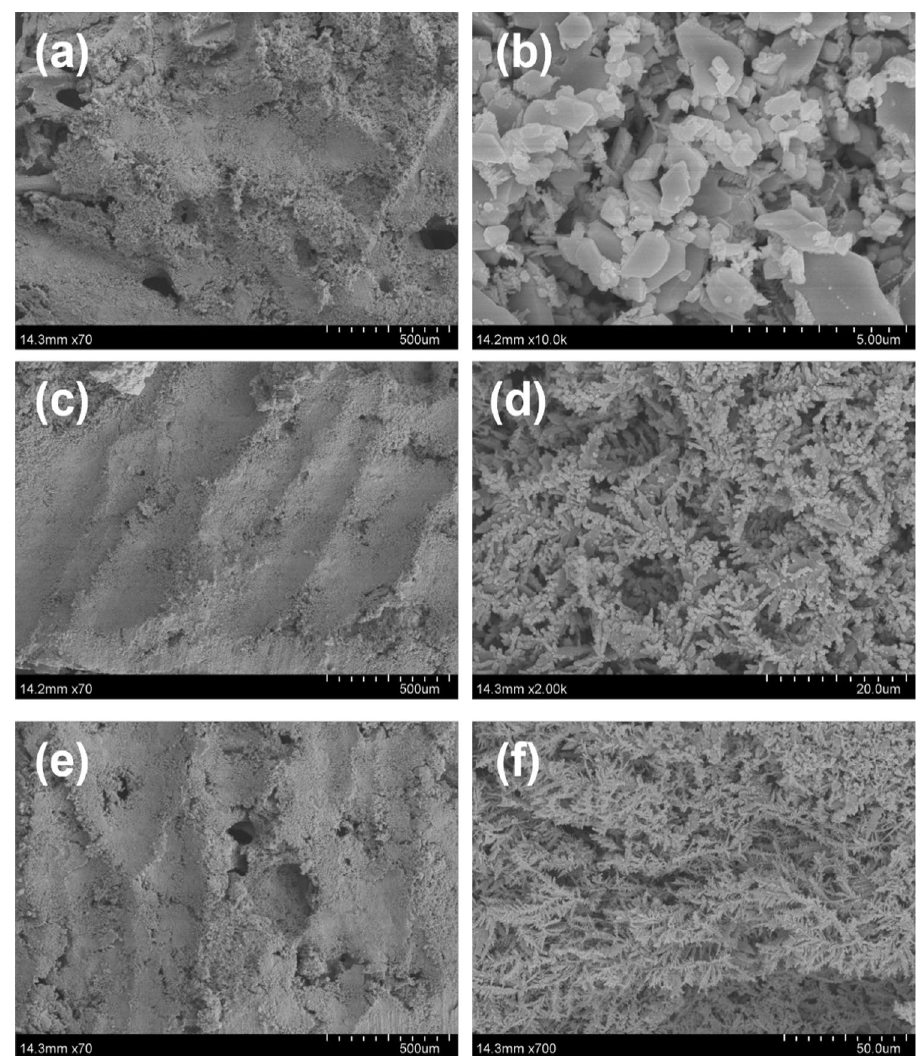
Fig. 2 Scanning electron microscope images of silver dendrites on the surface of copper foam by electrochemi- cal deposition of silver nitrate for 4 min ( a , b ), 6 min ( c , d ), and 8 min ( e , f